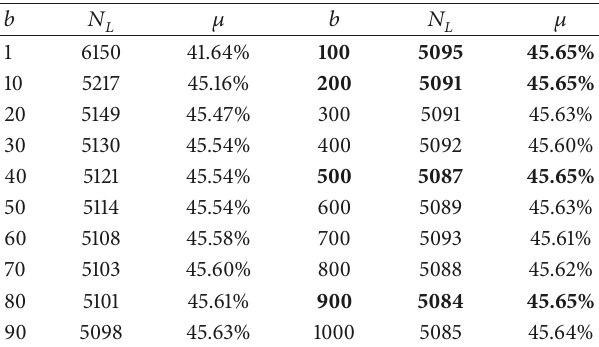
Table 5: The learned preference when 𝑏 is set to different values.